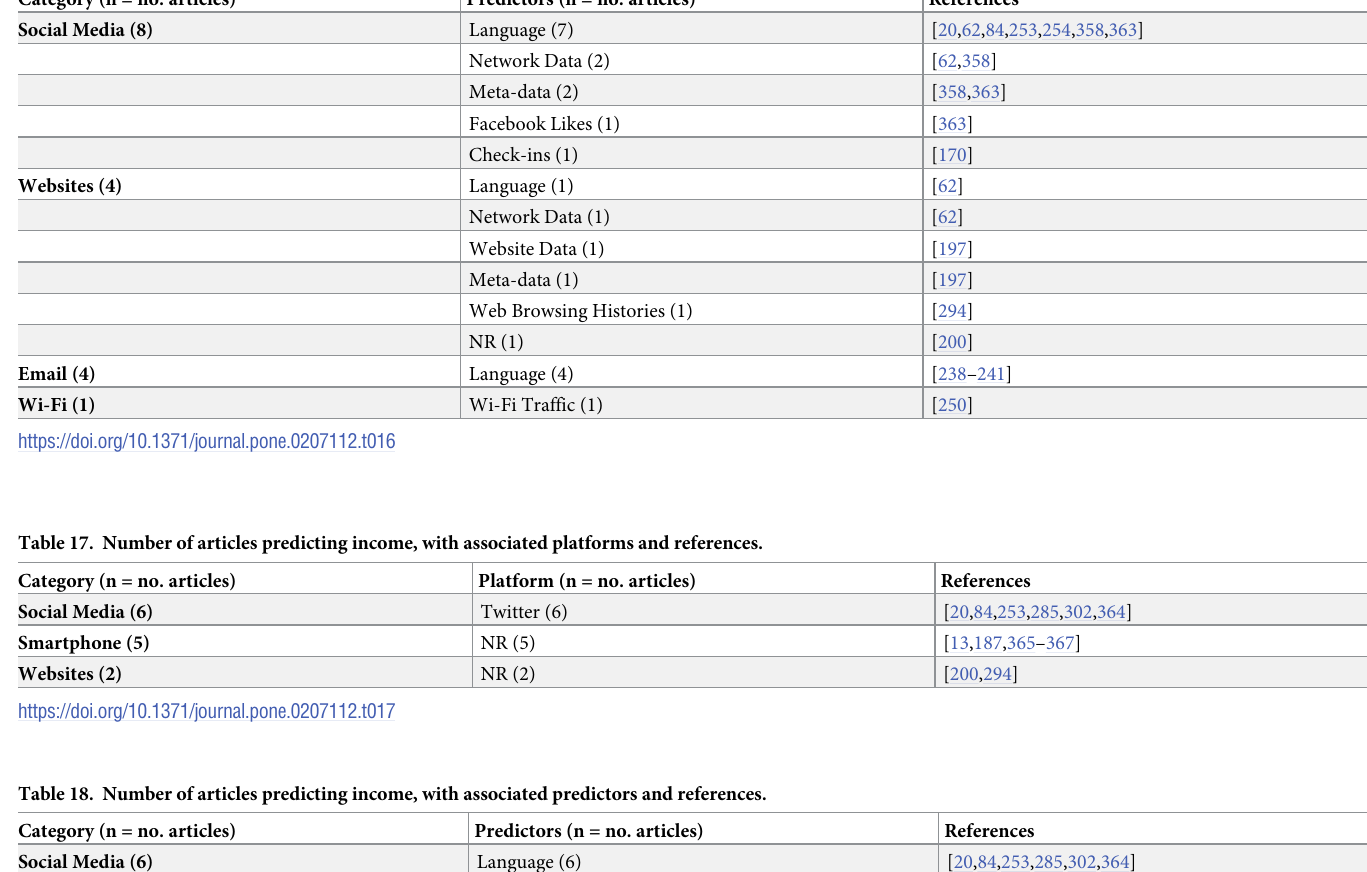
Table 16. Number of articles predicting education level, with associated predictors and references. Category (n = no. articles)